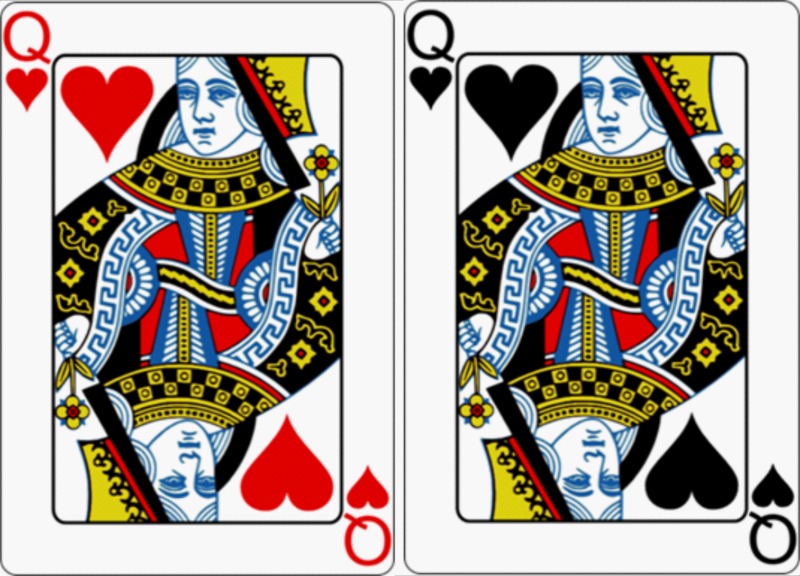
Stimuli of the card task.Examples for normal (left) and anomalous playing cards (right) used in the experiment.